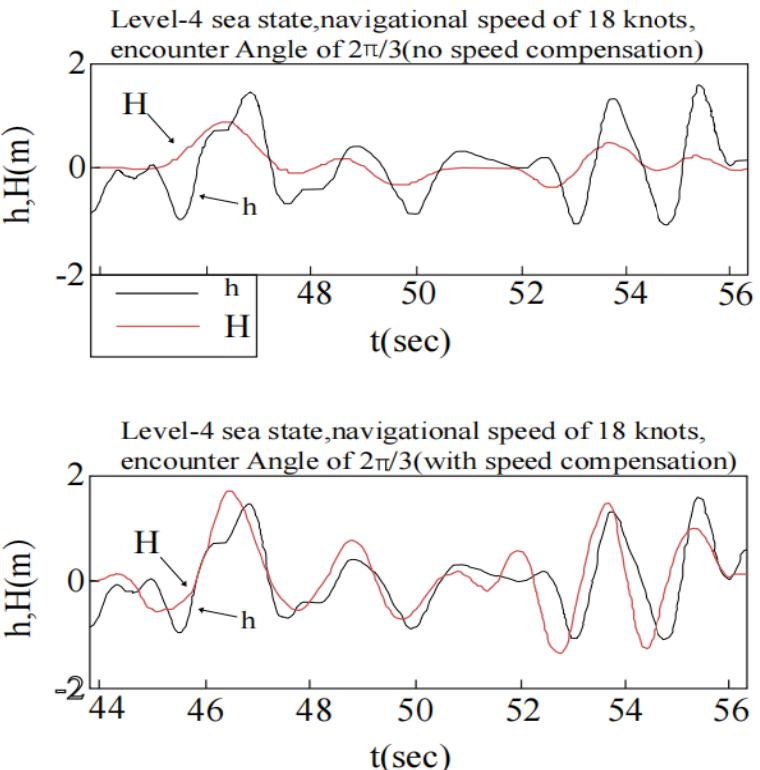
Figure 19. Response curves of aircraft tracking deck motion under level-4 sea state, speed V = 18 Kn and encounter angle β = 2 π /3.